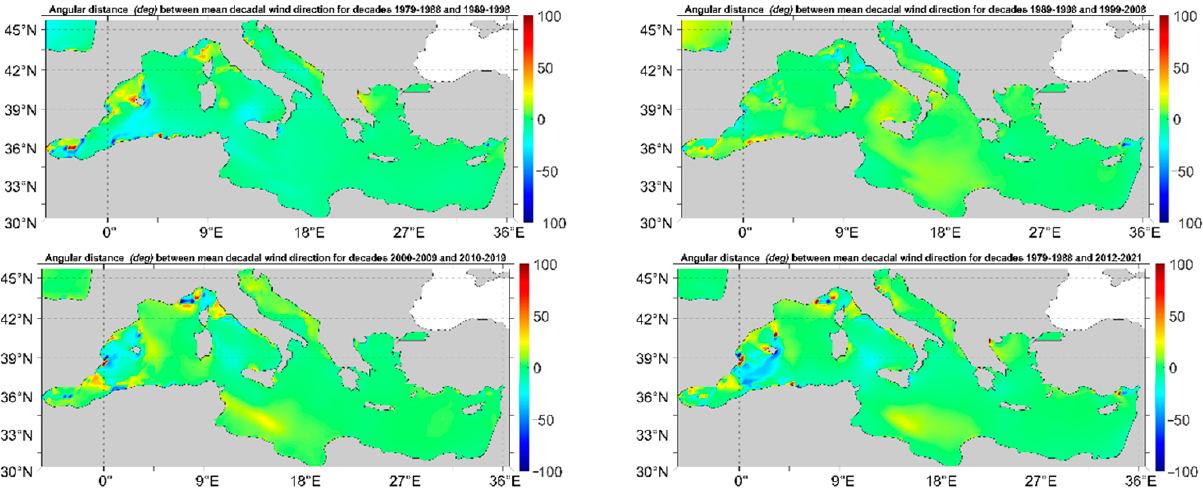
Figure 6. Angular distance between the decadal mean wind directions.